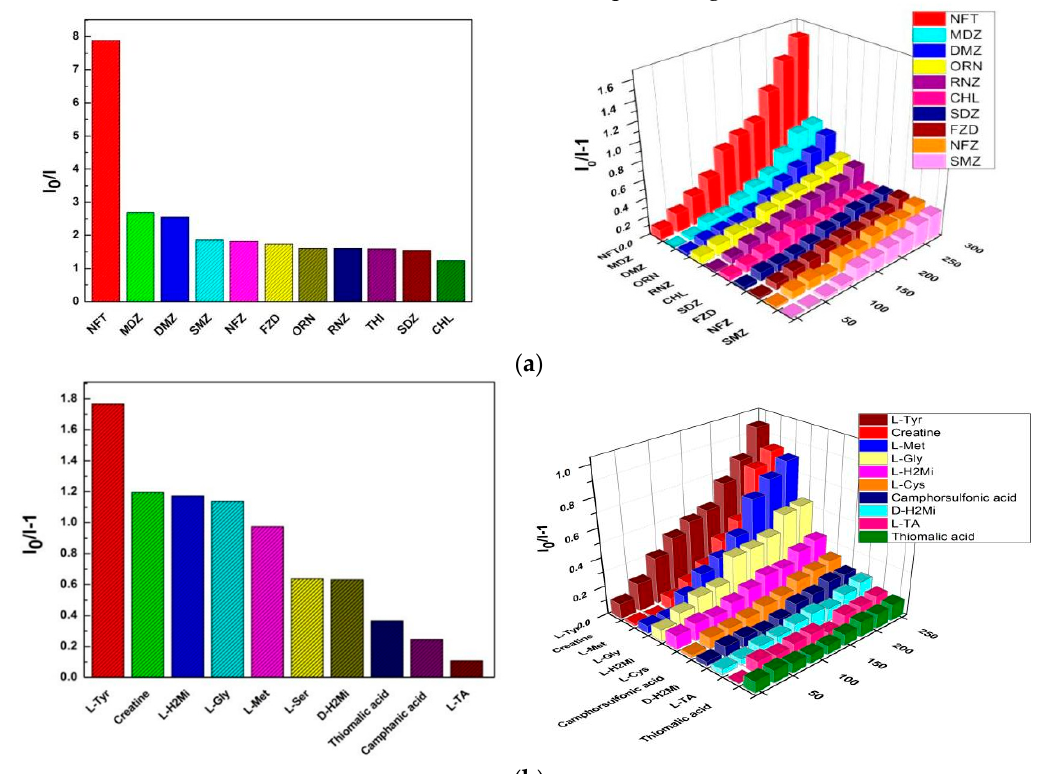
Figure 4. ( a ) Photo-luminescent intensities at 353 nm for 1 in the presence of different antibiotics; ( b ) photo-luminescent intensities at 353 nm for 1 in the presence of different amino acids.